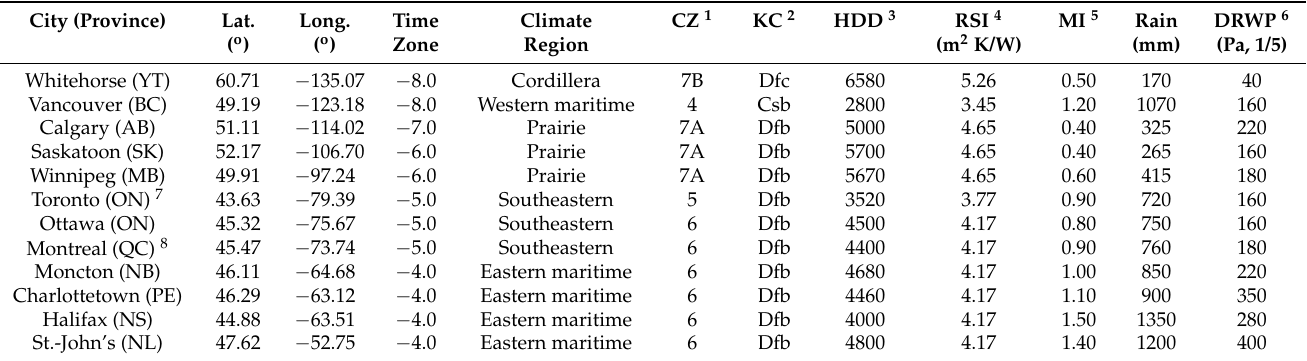
Table 1. Geographical location and climate design data for the selected